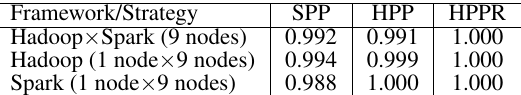
Table 1. Comparison of the segmentation outcomes according to Hoover metric.